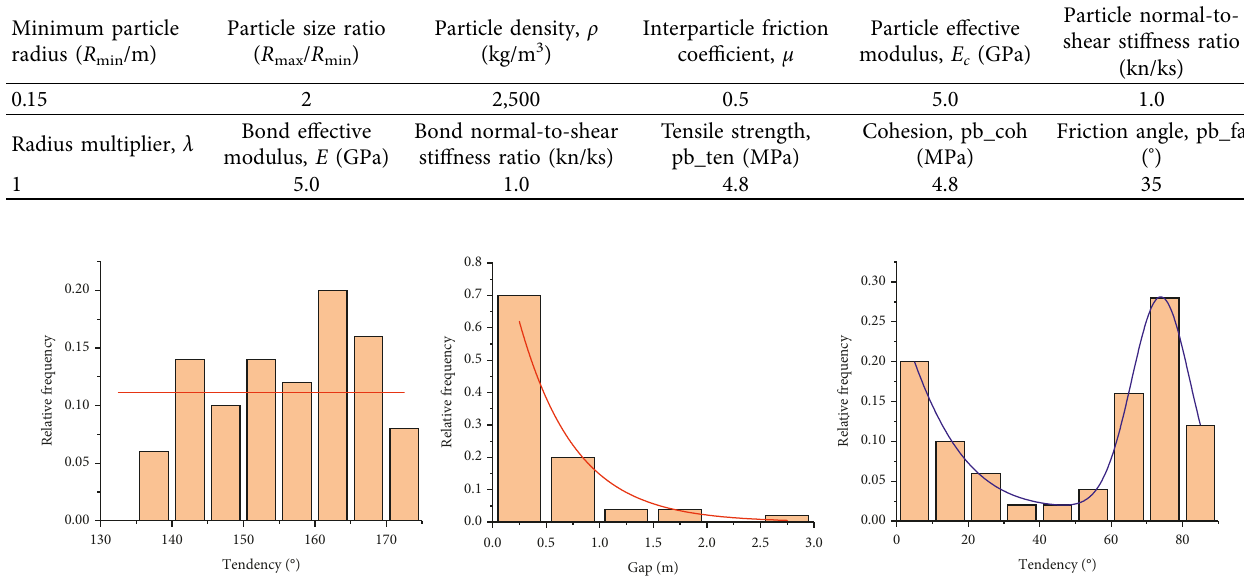
Figure 4: Histogram and probability density curve of joint tendency and dip angle.